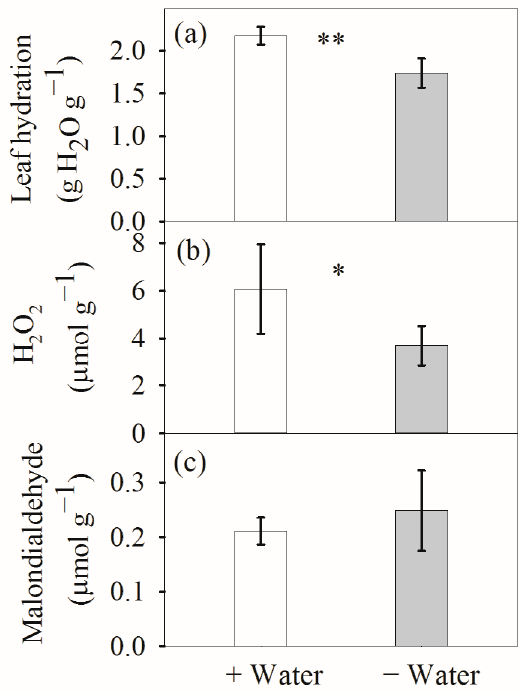
Figure 3. Leaf hydration ( a ), hydrogen peroxide ( b ), and malondaldehy contents ( c ) of Alnus glutinosa grown under sufficient (+ water, blank bars) and limited water conditions ( − water, grey bars). Data shown represent mean ± standard deviation ( n = 5) on a dry weight basis. Asterisks indicate significant differences between trees with sufficient and limited water supply at p < 0.05 (*) and 0.01 (**) respectively.